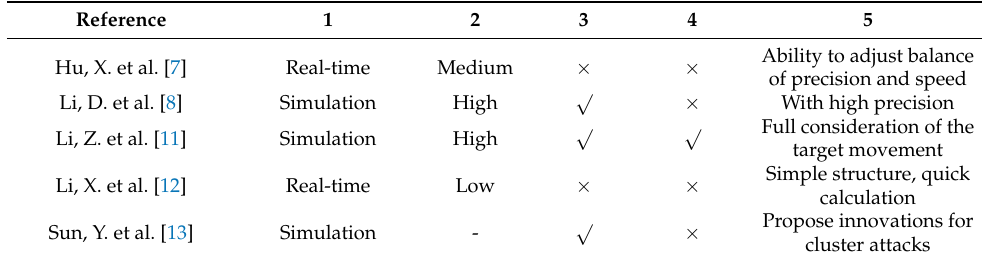
Table 1. Relative comparison of existing proposals in